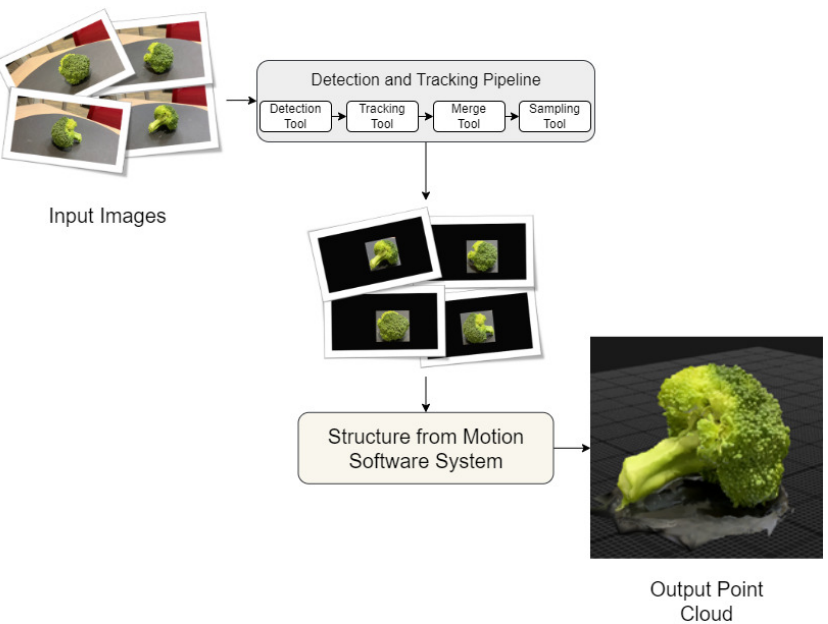
Figure 4. Abstract view of our Proposed